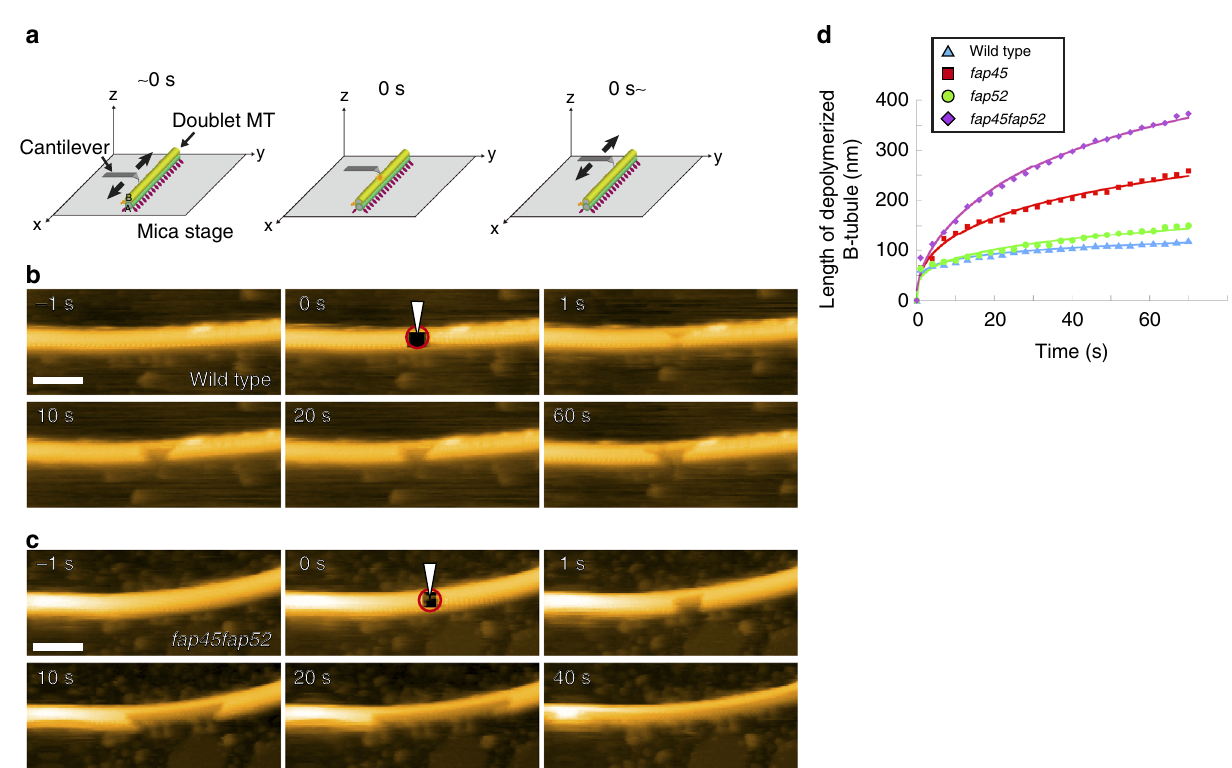
Fig. 5 Direct observation of B-tubule depolymerization by HS-AFM. a Schematic of high speed-AFM observation of the DMT. The tip of the cantilever (tip diameter ~1 – 2 nm) intermittently tapped the DMT surface on a mica stage. At time 0 s, the tip of the cantilever was thrust into the B-tubule and made a small hole (circled in red in b and c ), immediately followed by normal HS-AFM observation. b , c Representative time-lapse images of wild type ( b ) and fap45fap52 ( c ) DMTs acquired by HS-AFM. In the wild type, enlargement of the hole usually stopped within a few seconds, whereas most of the B-tubules in the fi eld were broken in fap45fap52 by 40 s. Scale bar = 100 nm. d The average length of the depolymerized B-tubules was plotted against time (wild type: n = 11, total length = 7.25 μ m; fap45 : n = 8, total length = 4.92 μ m; fap52 : n = 7, total length = 3.83 μ m; fap45fap52 : n = 10, total length = 4.95 μ